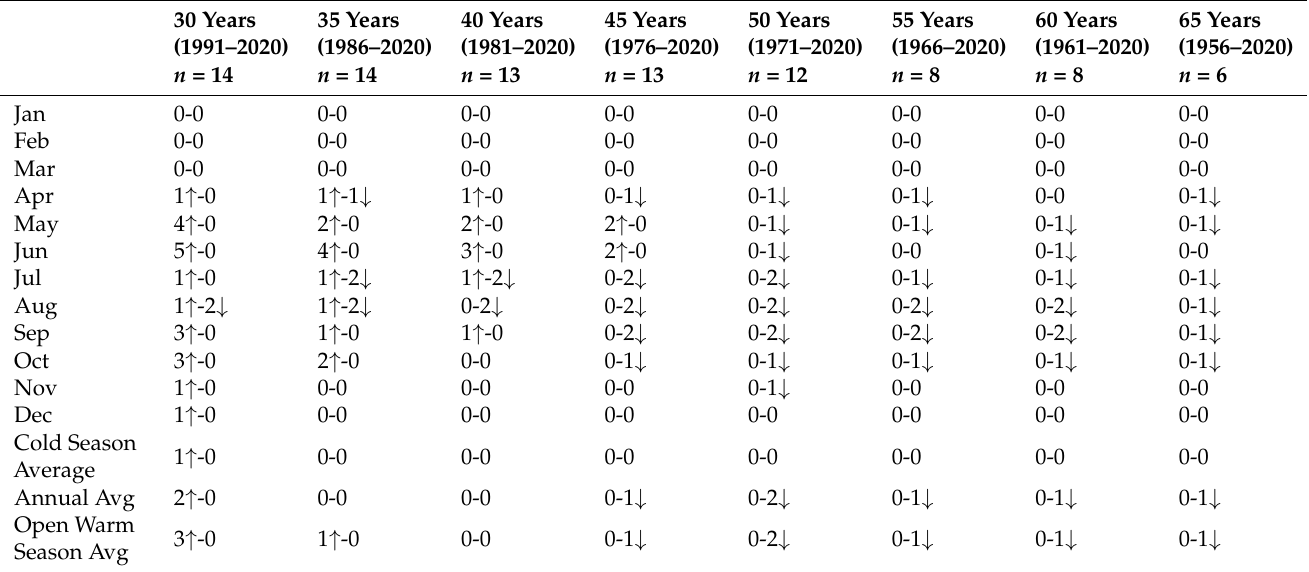
Table 4. Number of gauging stations with a significant increasing ( ↑ ) or decreasing ( ↓ ) water flow trend ( ≥ 90% significance) in the ARB.